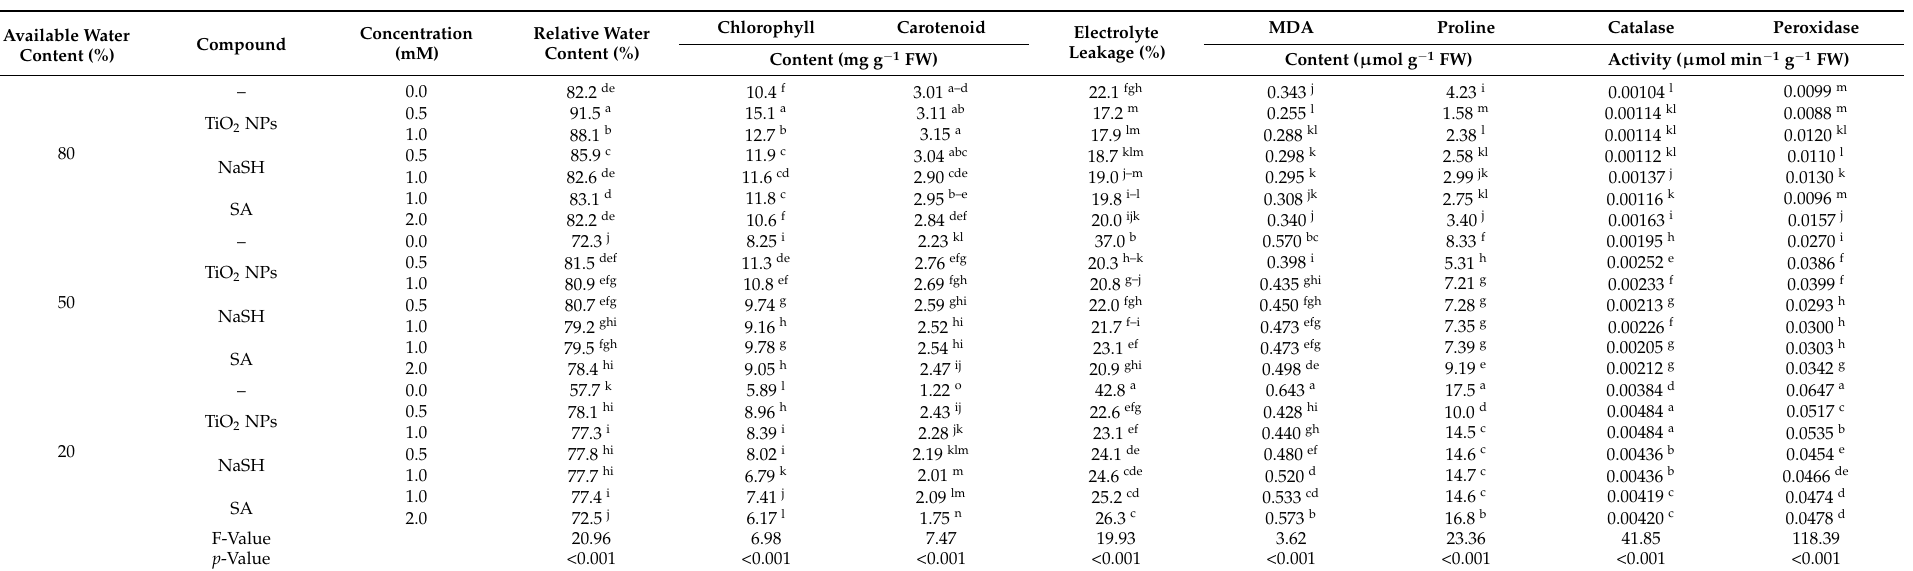
Table 6. Relative water content, electrolyte leakage, content of chlorophyll, carotenoids, and malondialdehyde (MDA), as well as peroxidase and ascorbate peroxidase activity of periwinkle ‘Pacifica XP Really Red’ plants receiving exogenous application of titanium dioxide nanoparticles (TiO 2 NPs; 0, 0.5 and 1 mM), sodium hydrosulfide (NaSH; 0.5 and 1 mM), or salicylic acid (SA; 1 and 2 mM) under different watering levels (80, 50 and 20% available water content) during cultivation. Means followed by different letters indicate significant differences ( p = 0.05; comparison in columns). Values are the mean of four replications. FW, fresh